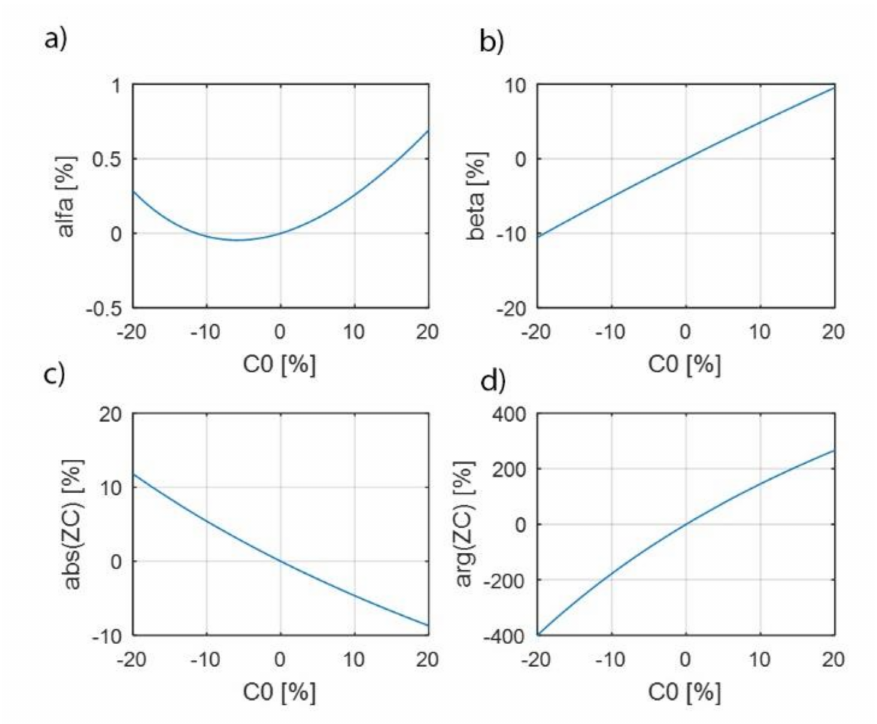
Figure 8. Changes of wave parameters depending on C 0 at f = 100 kHz; ( a ) damping factor α , ( b ) phase factor β , ( c ) wave impedance modulus, and ( d ) wave impedance